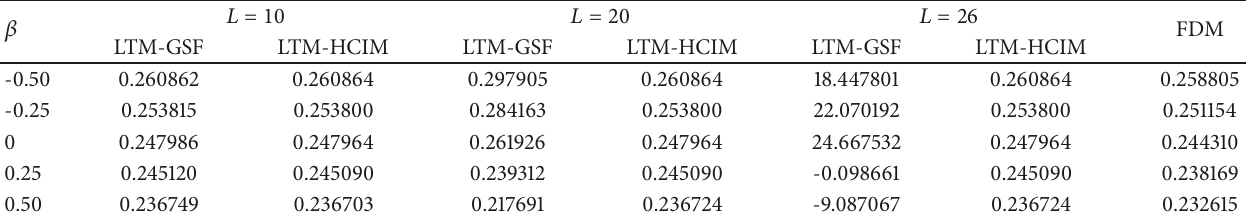
Table 1: Values of American Strangles at time 𝑡 = 0 (i.e., 𝜏 = 𝑇 ) with 𝐾 1 = 1 , 𝐾 2 = 1.5 , 𝑟 = 0.05 , 𝑞 = 0.1 , 𝑆 0 = 1.5 , 𝜎 0 = 0.4 , different values of 𝛽 , and different values of 𝐿 . The CPU time is about 20s, 22s, and 680s for LTM-GSF, LTM-HCIM, and FDM,